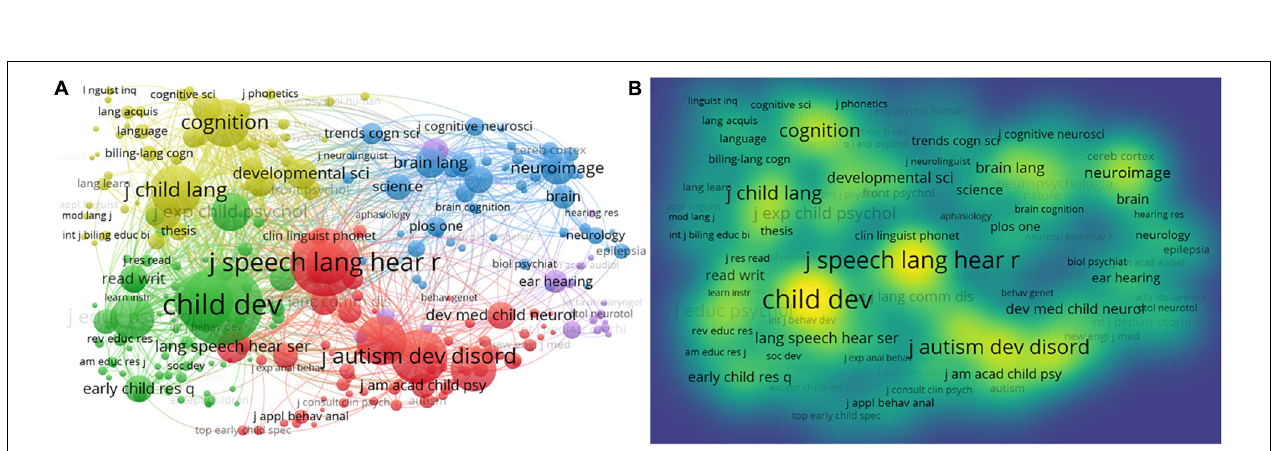
FIGURE 12 | Journal co-citation networks of CL. (A) Journal co-citation network visualization; (B) journal co-citation density visualization.